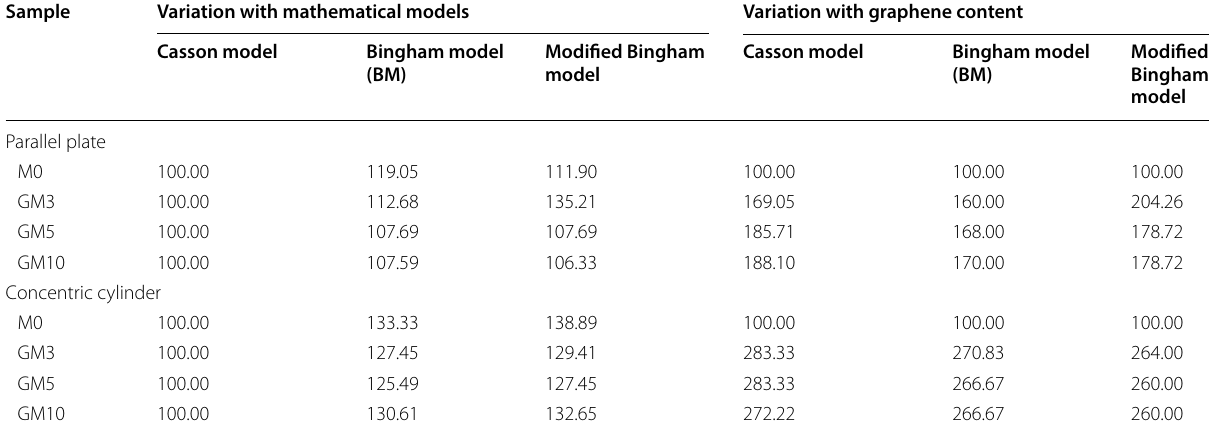
Table 10 Variation of plastic viscosity with mathematical models and graphene content. Sample